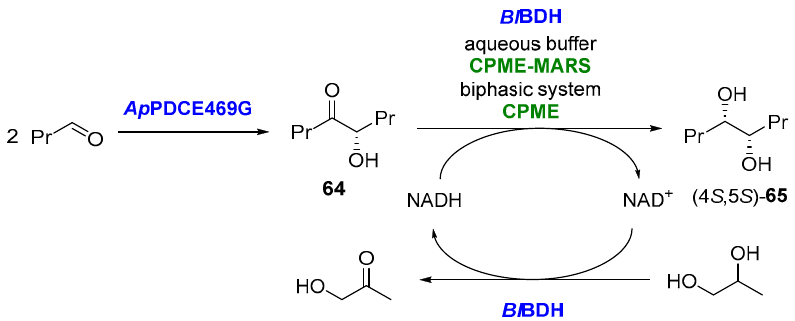
Figure 33. Biocatalytic cascade leading to (4 S ,5 S